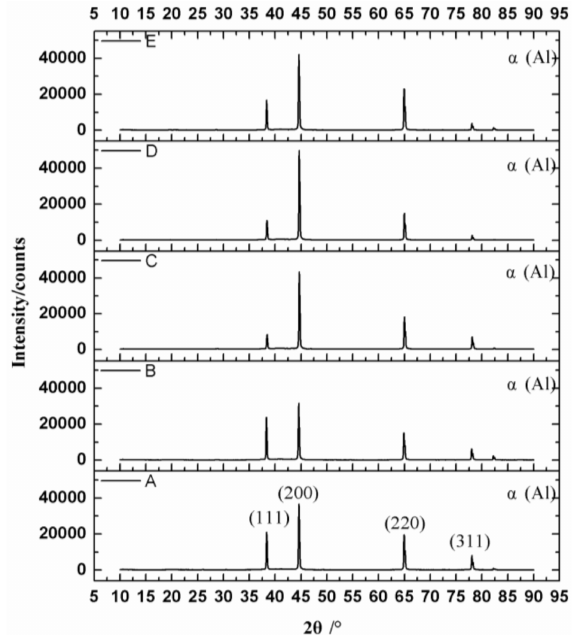
Figure 6. X-ray diffractometer (XRD) patterns of the 7075 alloys samples with CTs of 25 ◦ C, 0 ◦ C, − 60 ◦ C, − 120 ◦ C, and − 196 ◦